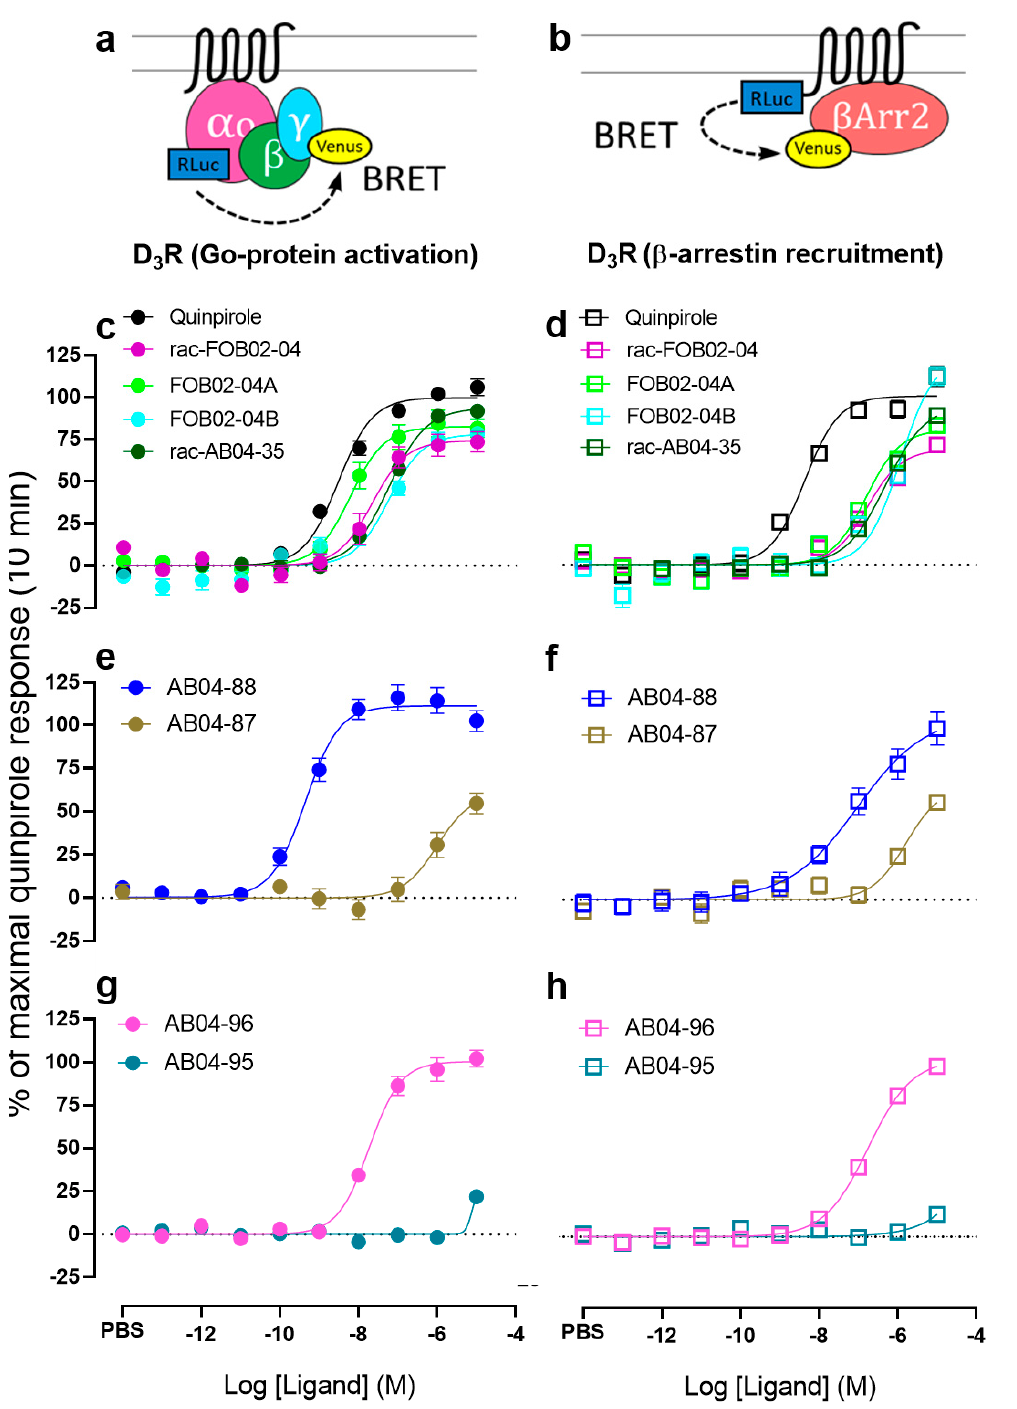
Figure 2. Pharmacological comparison of D 3 R bitopic ligands in both G protein activation and β -arrestin recruitment at 10 min. ( a ). Scheme for the bioluminescence resonance energy transfer (BRET) between G α o-RLuc and G γ -Venus. ( b ). Scheme for the BRET between D 3 R-RLuc and β -arrestin2-Venus. Concentration-response curves (CRCs) of drug-induced BRET at 10 min between G α o-RLuc and G γ -Venus ( c , e , g ). CRCs of drug-induced BRET at 10 min between D 3 R-RLuc and β -arrestin2-Venus ( d , f , h ). CRCs are plotted as percentage of maximal response by quinpirole and presented as means ± SEM of n ≥ 3 independent experiments.